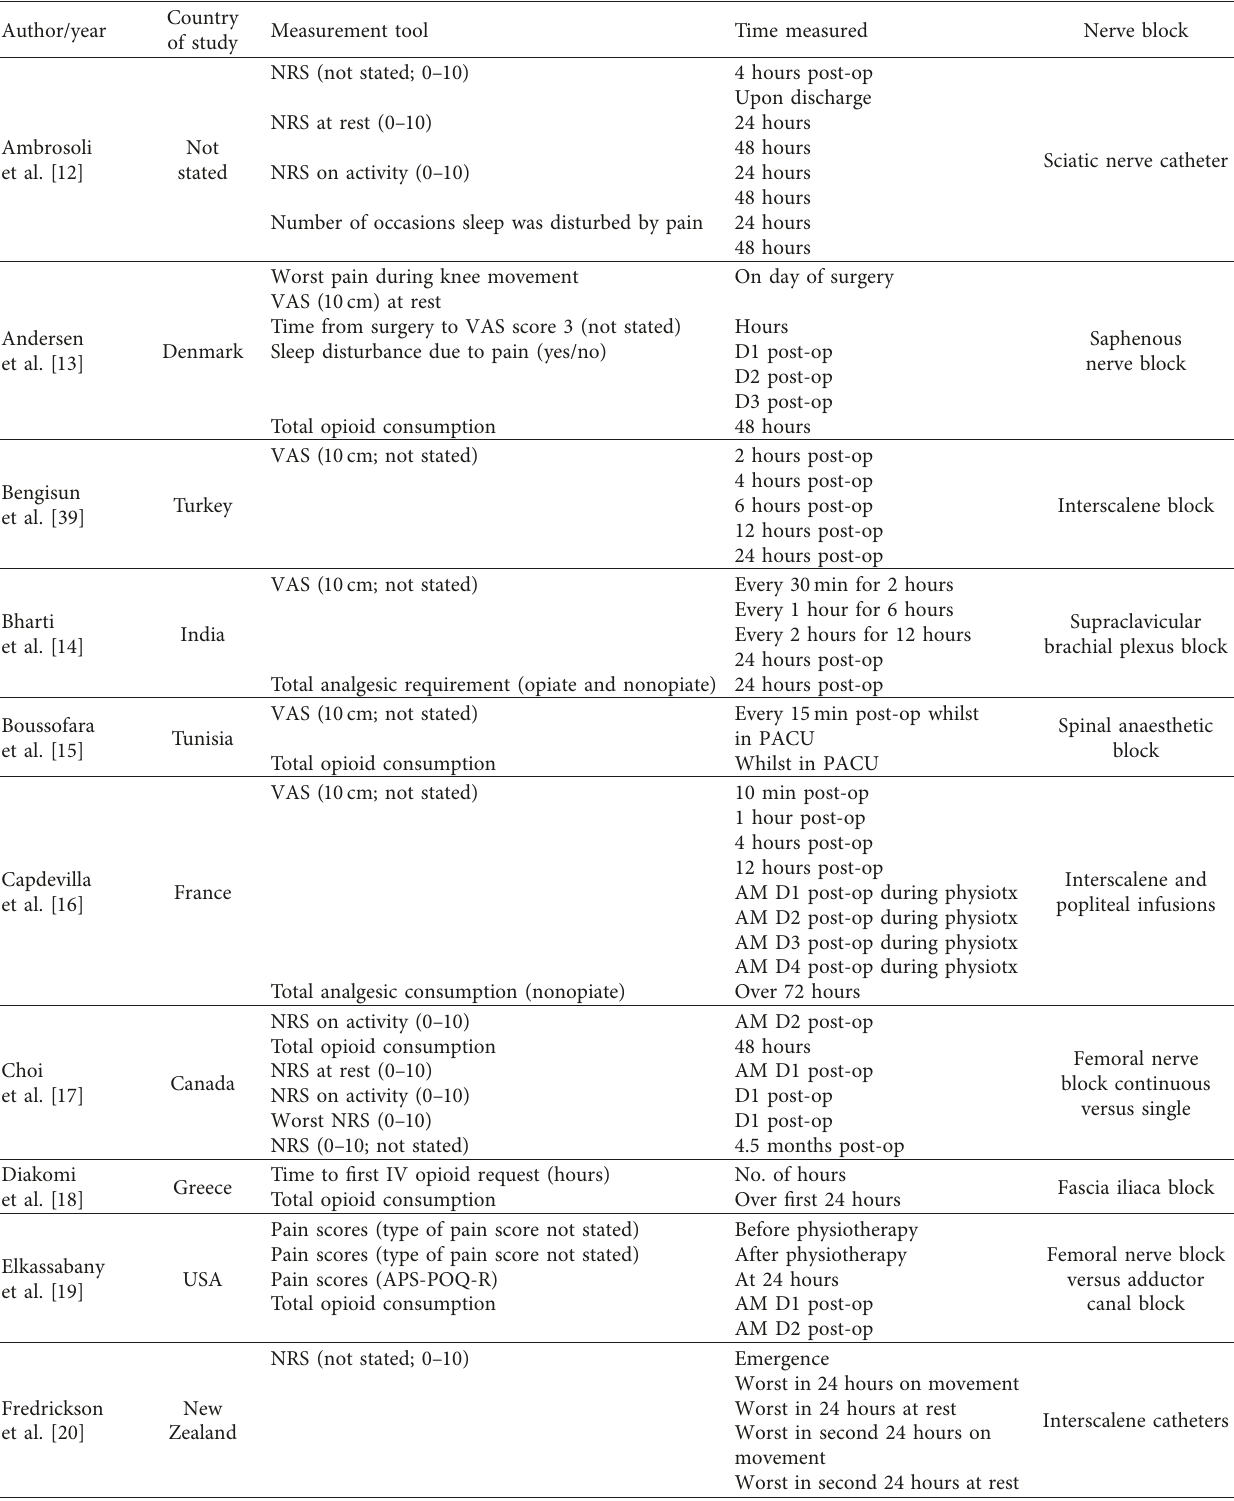
Table 1: Summary of measurement timings of pain outcomes utilised in included